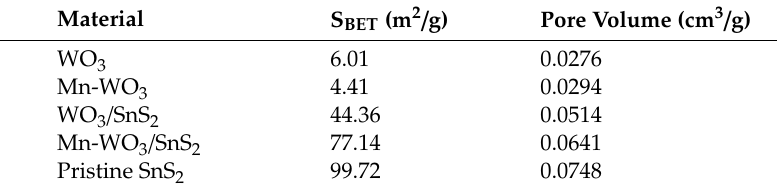
Table 1. The specific surface area and pore volume of NPs.